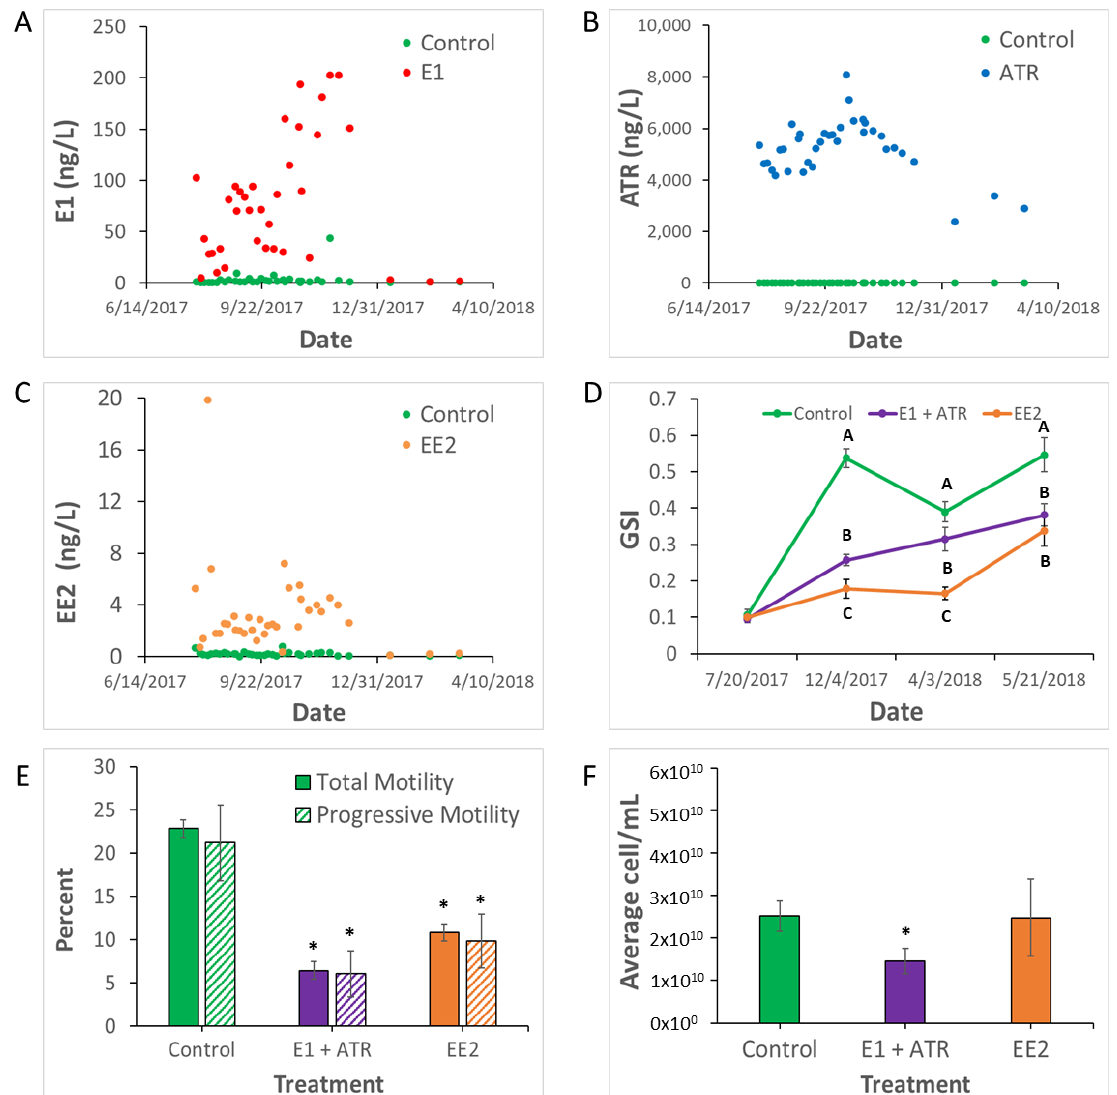
Figure 1. Summary of water chemistry and male largemouth bass (LMB; Micropterus salmoides ) reproductive condition: ( A , B ) concentrations of estrone (E1; green = concentration in control pond, red = concentration in dosed ponds) and atrazine (ATR; green = concentration in control pond, blue = concentration in dosed ponds) as measured in the mixture and control ponds at each weekly sampling and averaged across ponds (n = 3); ( C ) concentration of 17alpha-ethinylestradiol (EE2) at each weekly sampling across ponds and averaged across ponds (n = 3); ( D ) mean gonadosomatic index (GSI; ± standard error) of male LMB at the four timepoints (see Table S1 for n), different letters denote significant differences ( p < 0.05); ( E ) percent total sperm motility (solid bars) and percent progressive sperm motility (hashed bars) at the April time point (Control n = 12, E1 + ATR n = 11, EE2 n = 15), just prior to spawning, asterisks denote significant differences compared to control ( p < 0.05); ( F ) sperm count (cell count per mL milt) at the April time point (Control n = 12, E1 + ATR n = 11, EE2 n = 10), just prior to spawning, asterisk denotes a significant difference compared to control ( p < 0.05).